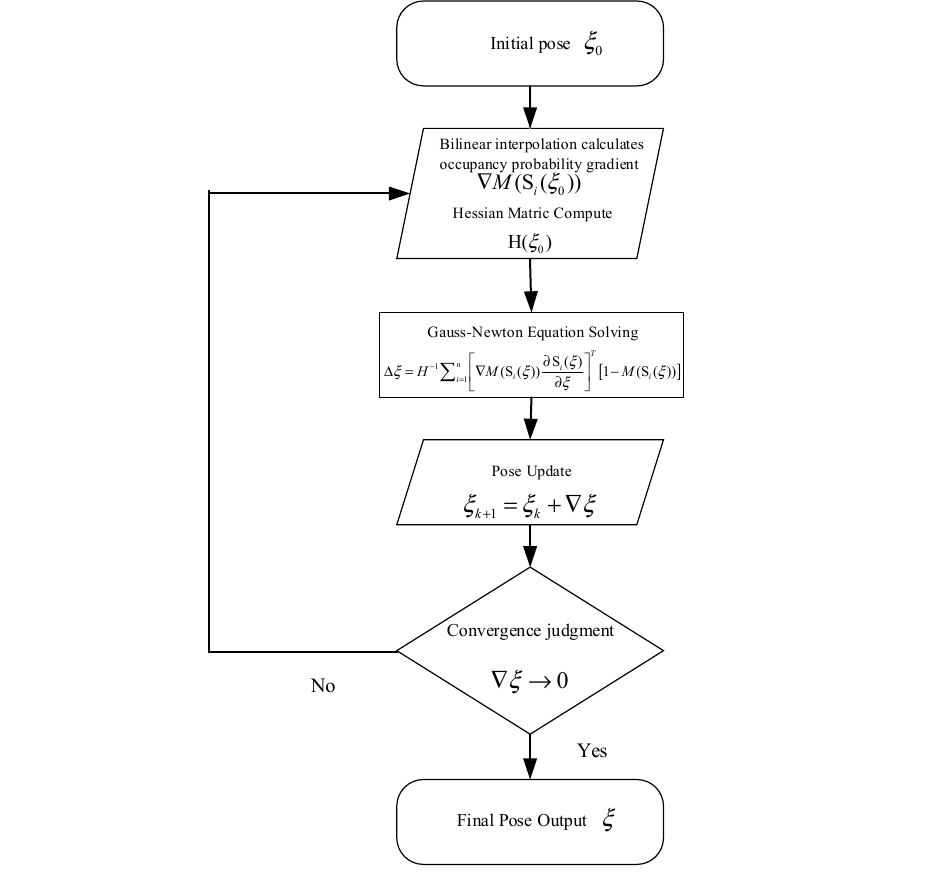
Figure 2. Scan-to-map matching algorithm.